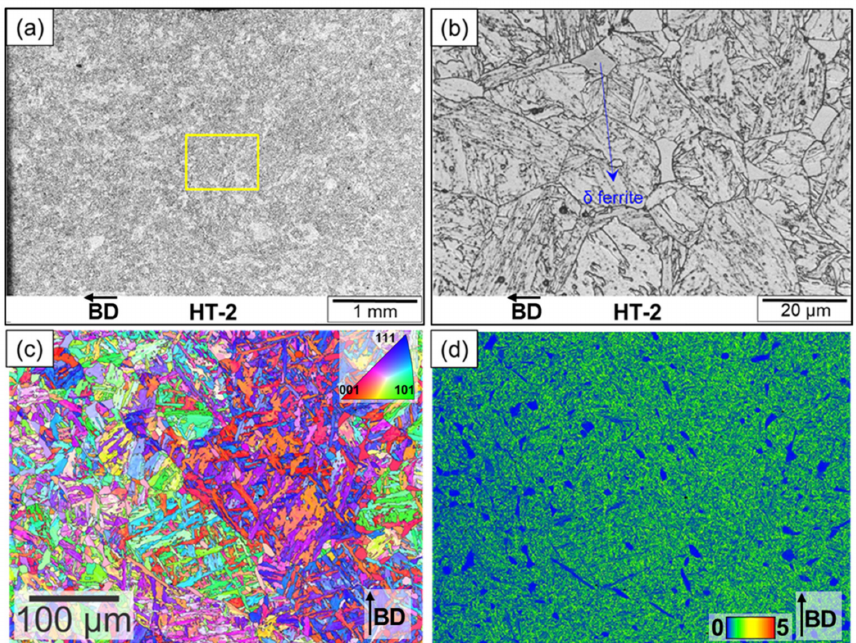
Figure 11. Characterization of the samples after PPHT (HT-2 treatment) ( a , b ). Optical micrographs showing a tempered martensitic structure with sporadic delta ferrite stringers ( c ). Inverse pole figure ( d ). Kernel average misorientation maps clearly show the presence of delta